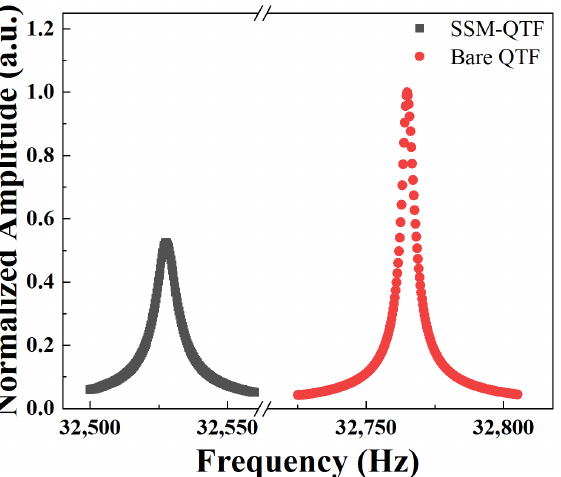
Figure 3. Conductance spectrum of a bare QTF without modification (red rounds) and after (black squares) modification by the spider silk. squares) modification by the spider